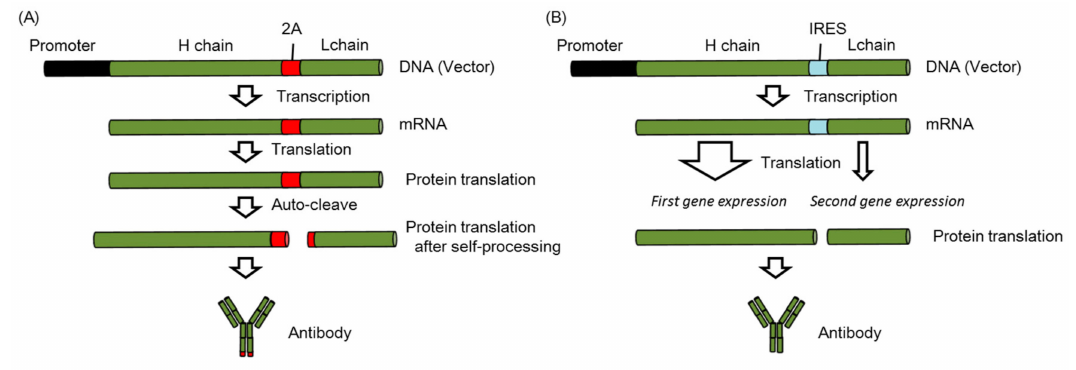
Figure 3. Antibody expression cassettes ( A ) The 2A peptide links the heavy (H) chain and light (L); ( B ) IRES links H chain and L